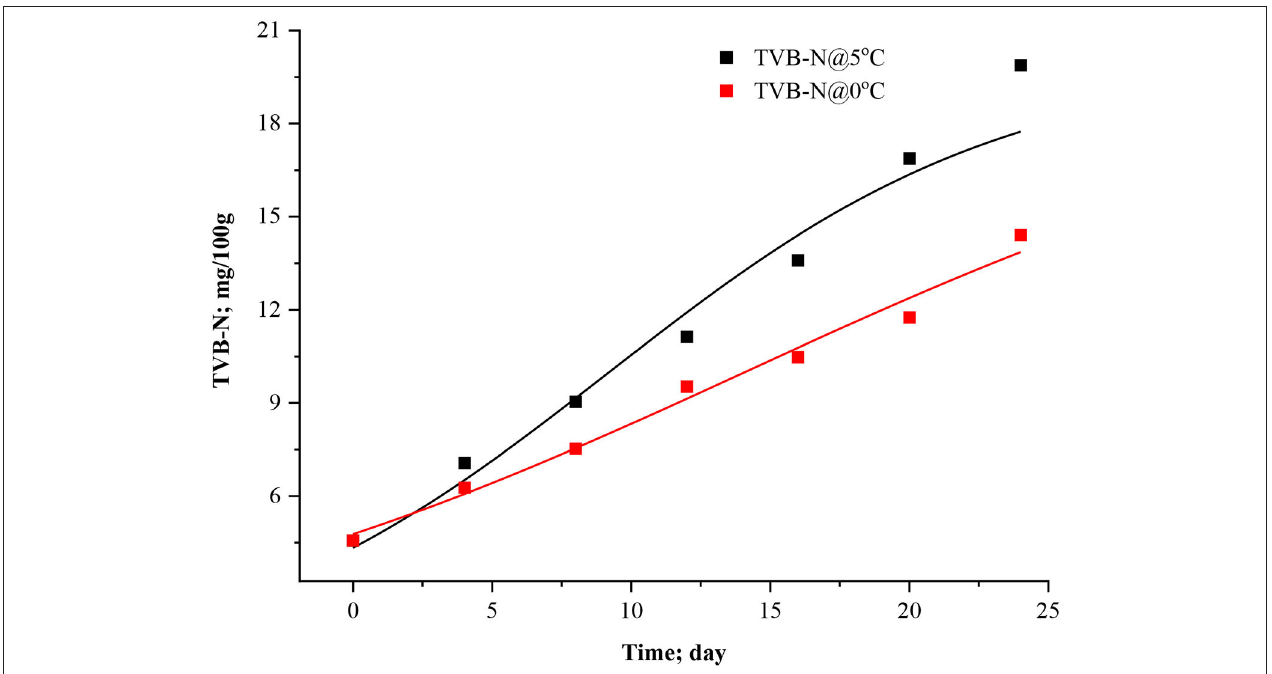
FIGURE 3 | Howgate model curve for TVB-N in stored Rohu